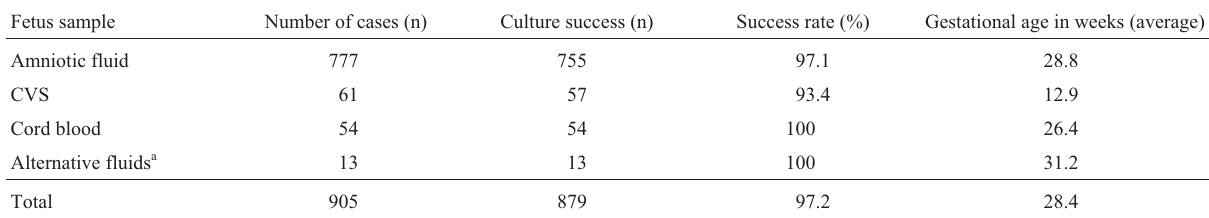
Table 2 - Source of fetal material for karyotyping and success rate of cell